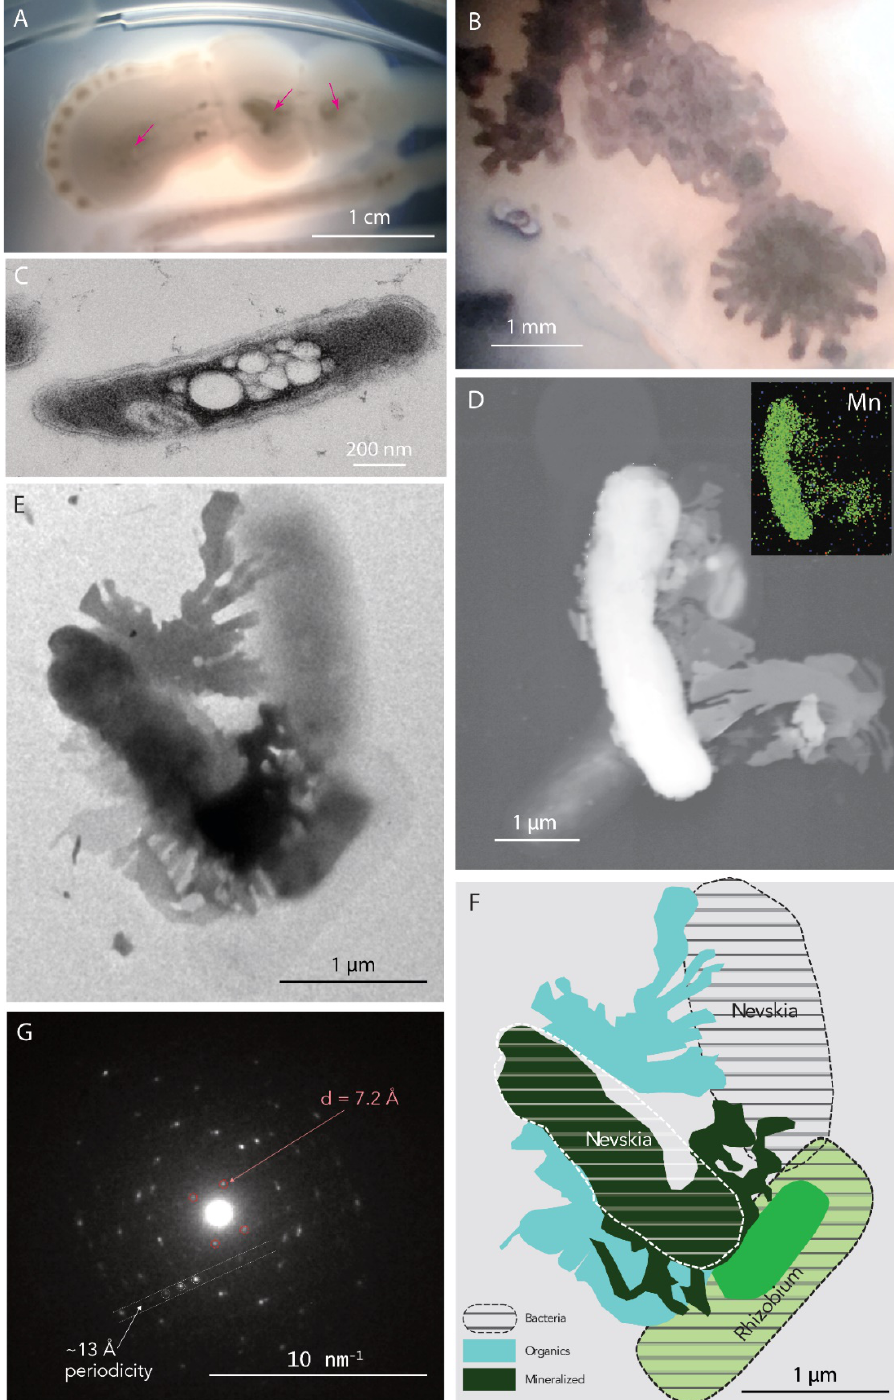
Figure 4. Micrographs of Nevskia - Rhizobium spp. and associated Mn mineralizations. ( A ) Mixed Nevskia - Rhizobium spp. colony grown on agar substrate with cluster of Mn precipitates in the center of the colonies (pink arrows). ( B ) Close-up of Mn precipitates. ( C ) Sheathed Nevskia sp. cell with intracellular globules (less electron dense), which possibly are gas vacuoles and/or carbon storage polymers. ( D ) SEM image of mineralized Nevskia sp. cell and associated organic matter (possibly their acellular stalks). ( E , F ) TEM image showing cluster of bacteria and organic matter and associated mineralizations. To the left, a mineralized Nevskia sp. cell and associated organic matter (possibly their acellular stalks). At the bottom right, a Rhizobium sp. bacterium containing electron dense angular particles inside the cell. ( G ) SAED of mineralized Nevskia sp. cell and associated organic matter in ( E